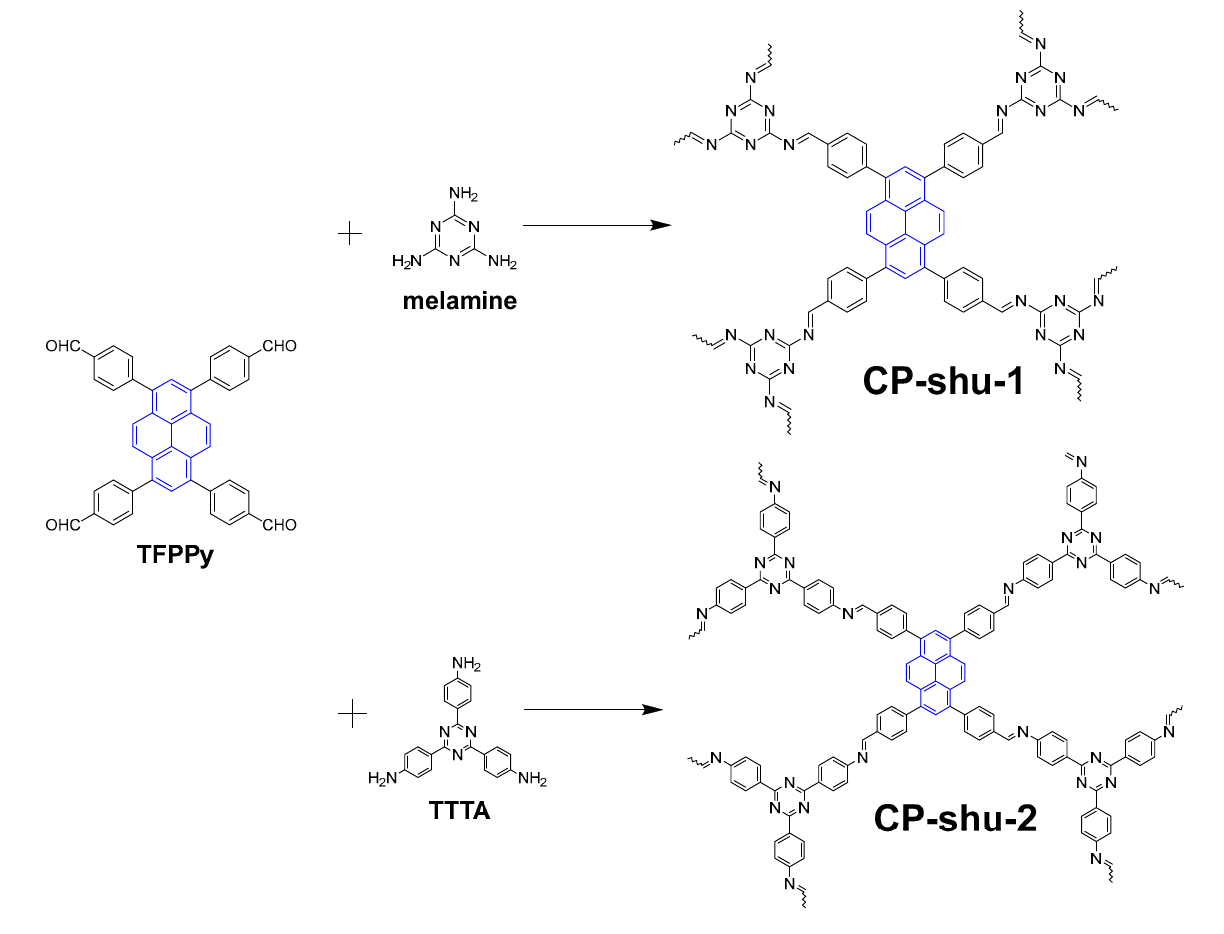
Figure 2. The preparation of CP ‐ shu ‐ 1 and CP ‐ shu ‐ 2. Preparation of CMP ‐ shu ‐ 1: TFPPy (185.0 mg, 0.30 mmol), melamine (50.4 mg,